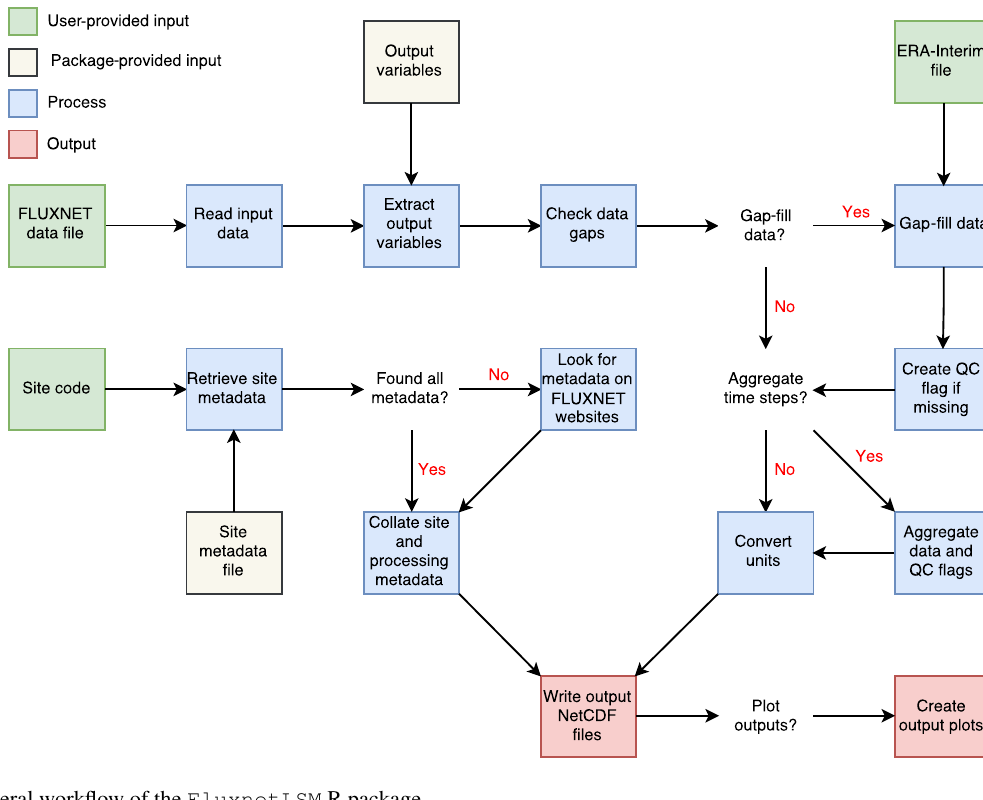
Figure 1. General workflow of the FluxnetLSM R